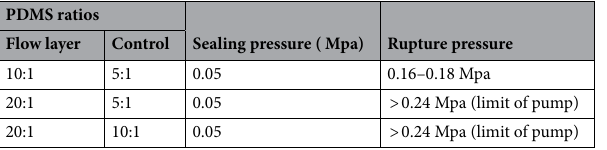
Table 1. Comparison of the sealing and rupture pressures of multi-layer microfluidic device with different PDMS ratios (N = 5).